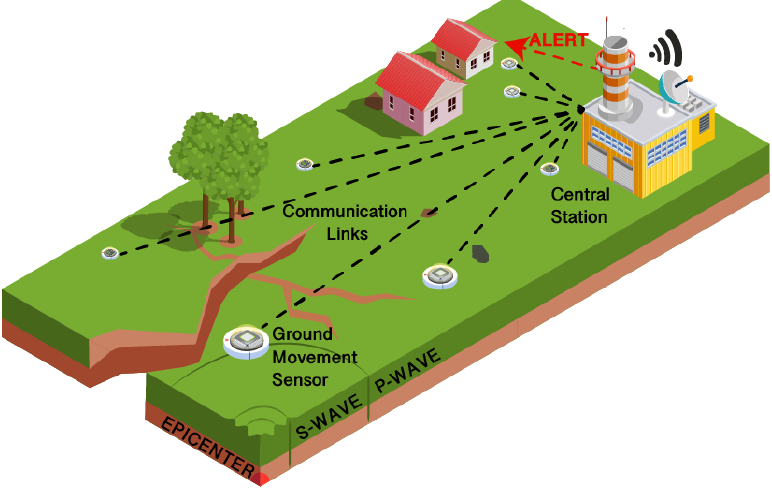
Figure 3. Example implementation of an Earthquake Early Warning System based on the IoT and P-wave